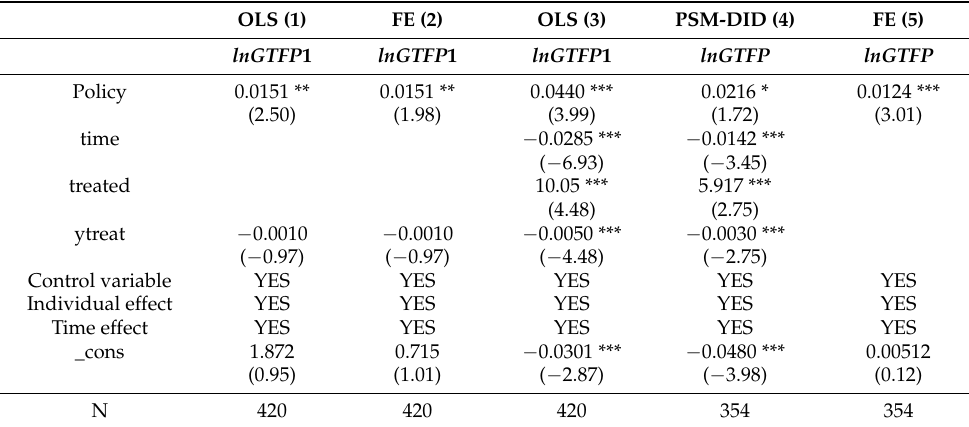
Table 6. Benchmark model and PSM-DID regression